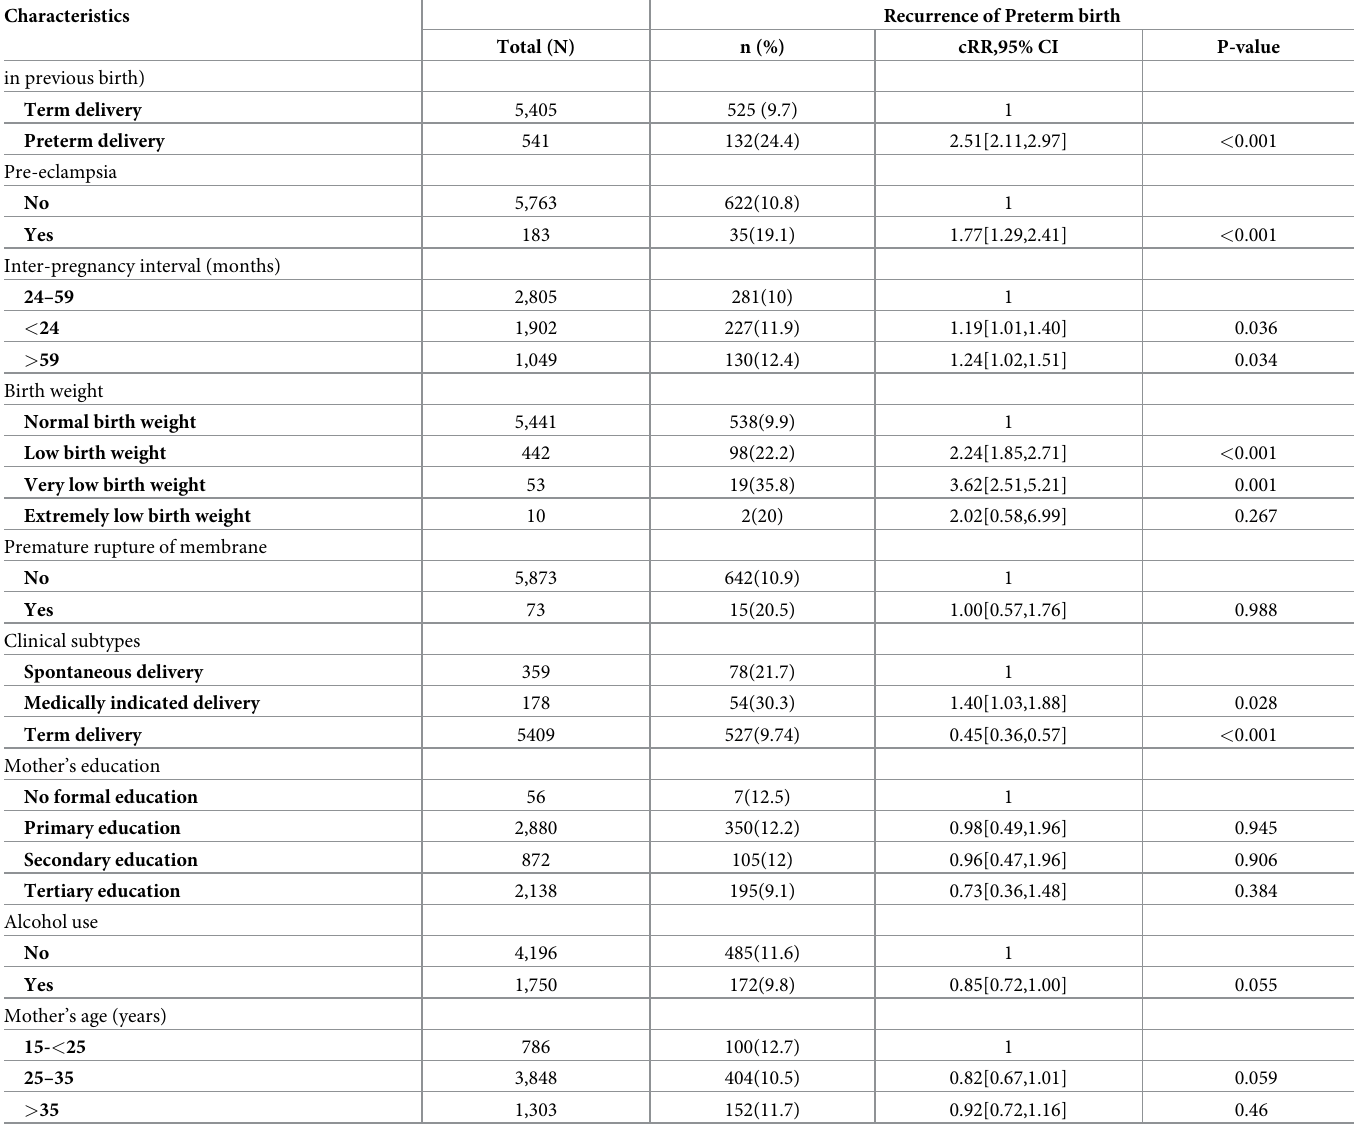
Table 4. Factors associated with recurrent preterm births among women delivered at KCMC (N = 5946).